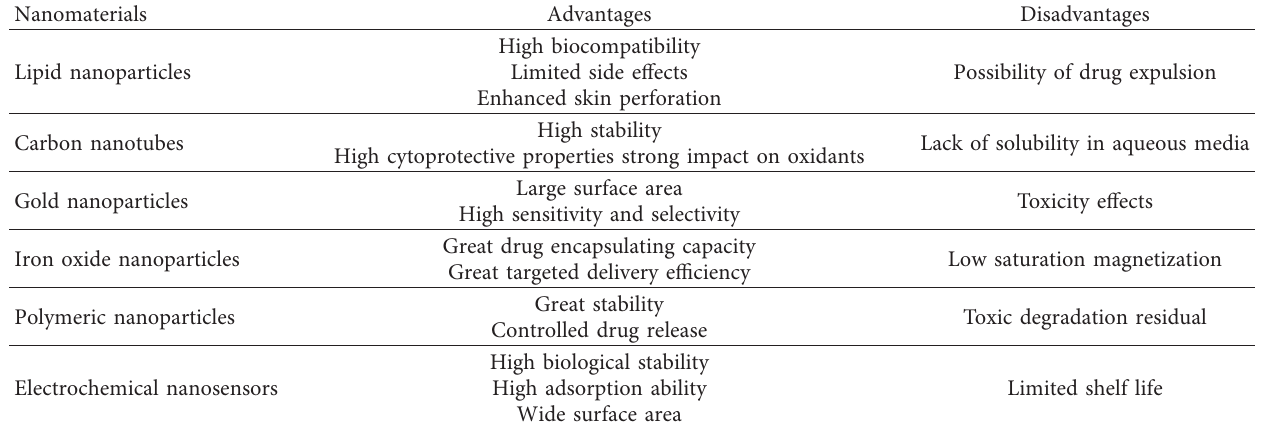
Figure 4: (a) Illustration of a packed electrochemical testing instrument. (b) Illustration of a needle-shaped electrode with 850m gold disc electrodes. (c) Diagram of the fabrication method used for device production. Table 1: Advantages and disadvantages of various types of nanoparticles used in skin cancer